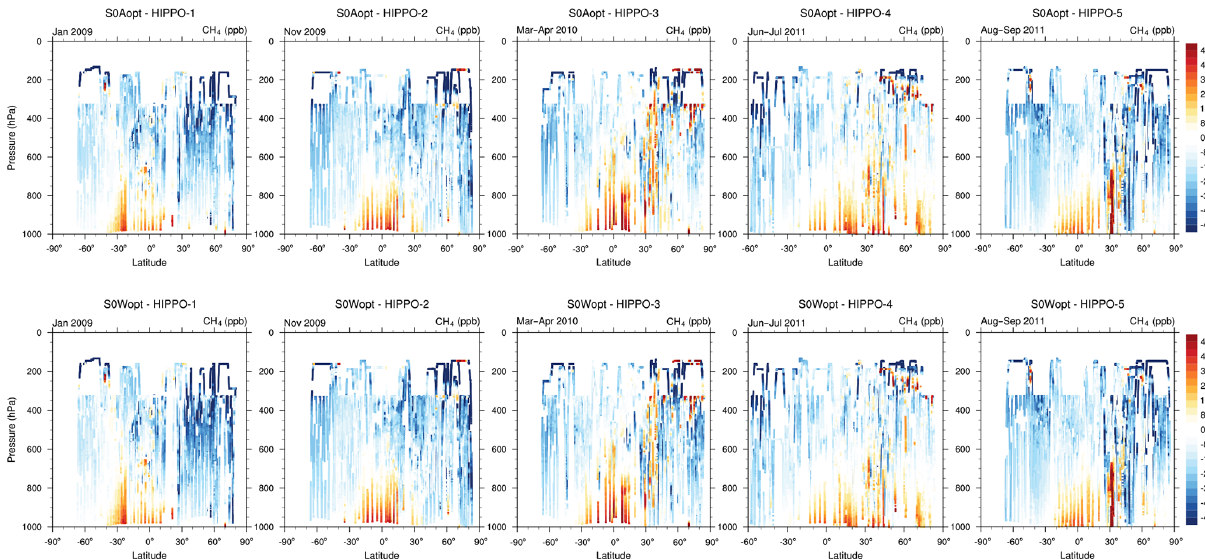
Figure 3. Comparison of vertical distribution of methane from S0Aopt and S0Wopt simulations with measurements from individual HIPPO campaigns. Months of campaign are given at the top left of the individual plots.